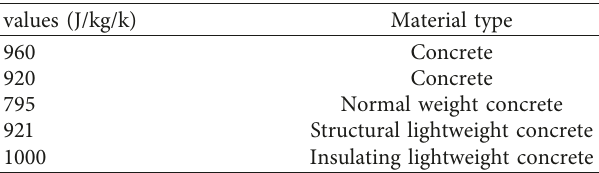
Table 7: Specific heat of concrete